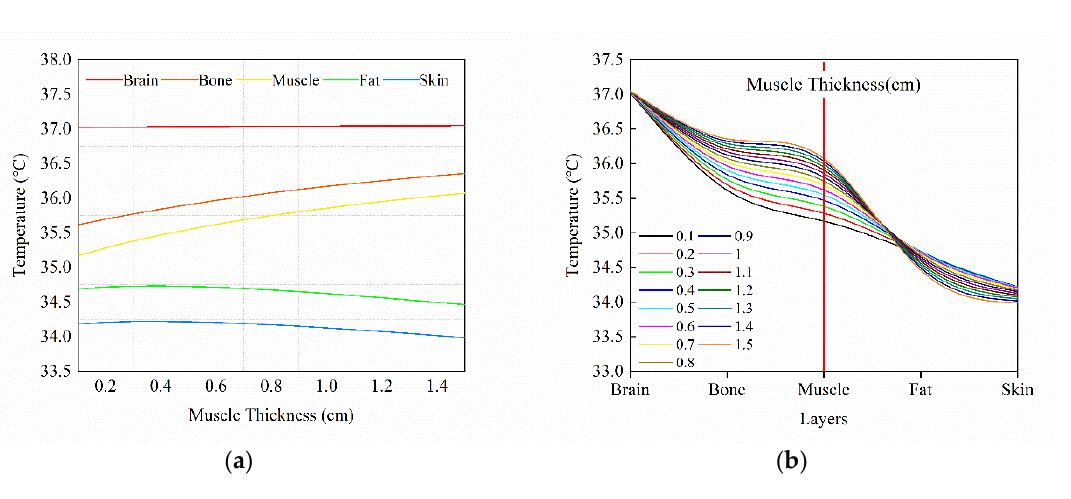
Figure 7. ( a ) Temperature variation by muscle thickness step change; ( b ) Tissues temperature distribution under different muscle thickness.